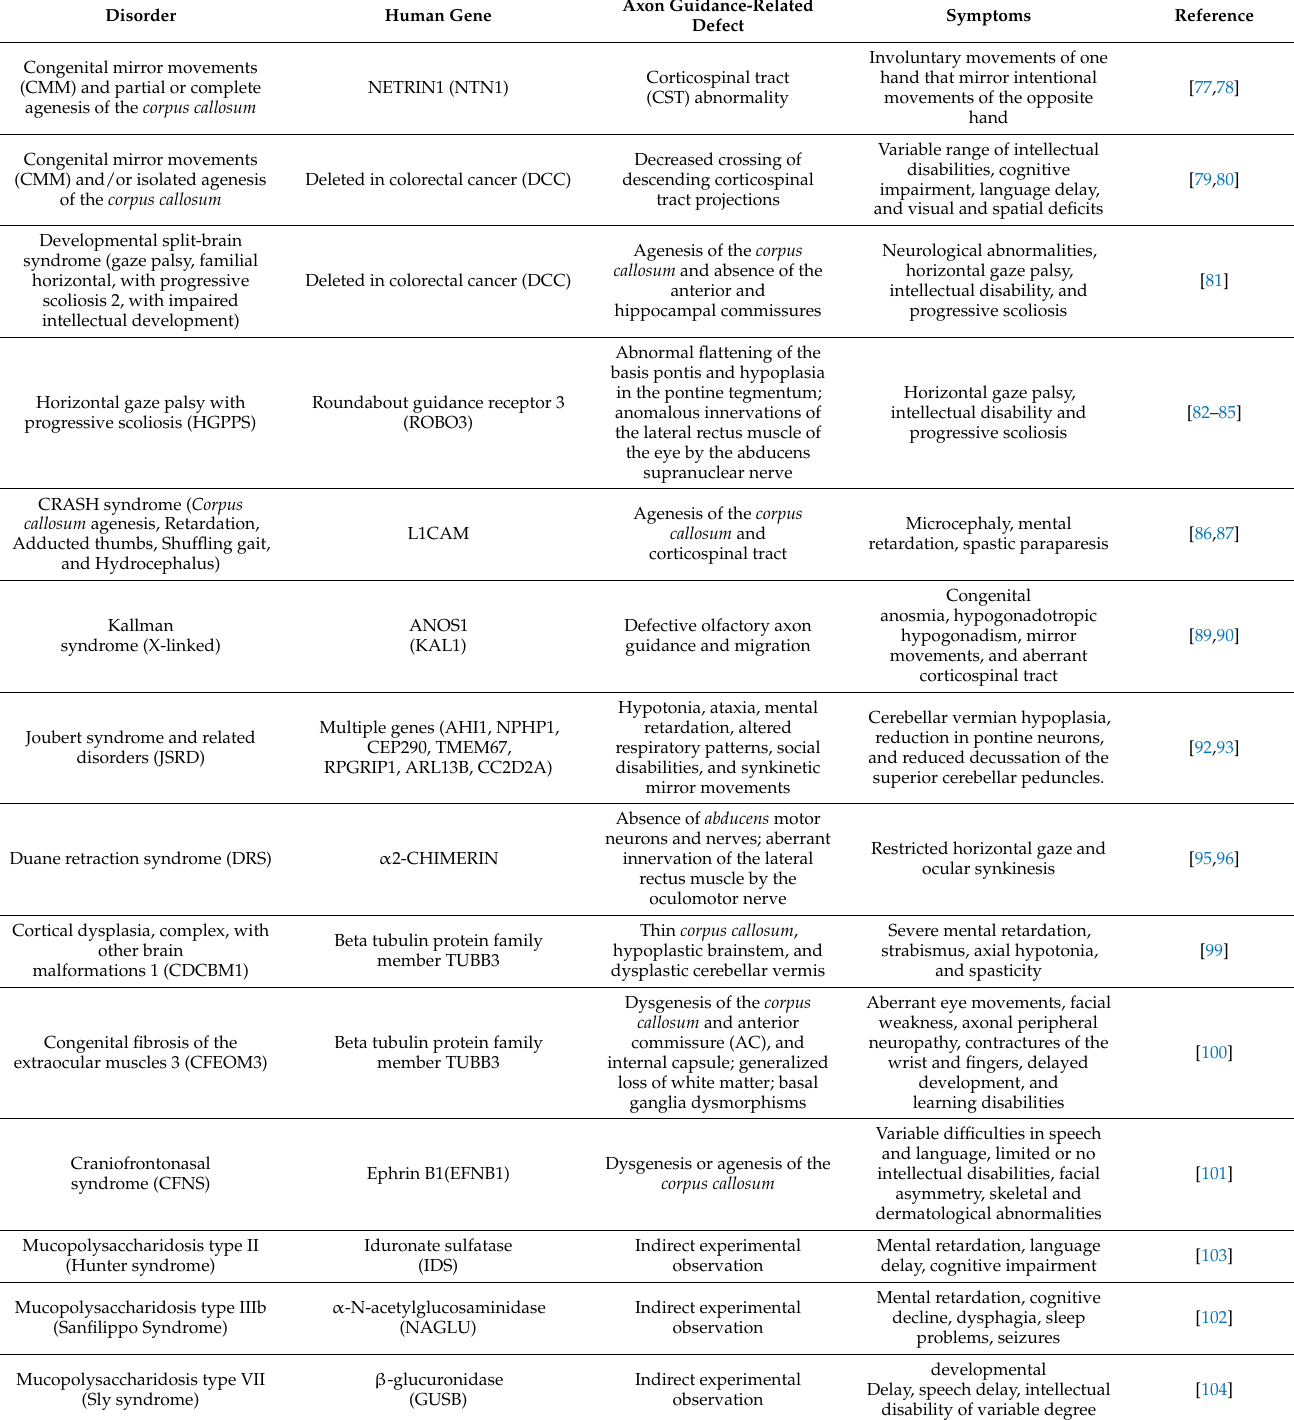
Table 1. Brain disorders in which axon guidance alterations have been described or